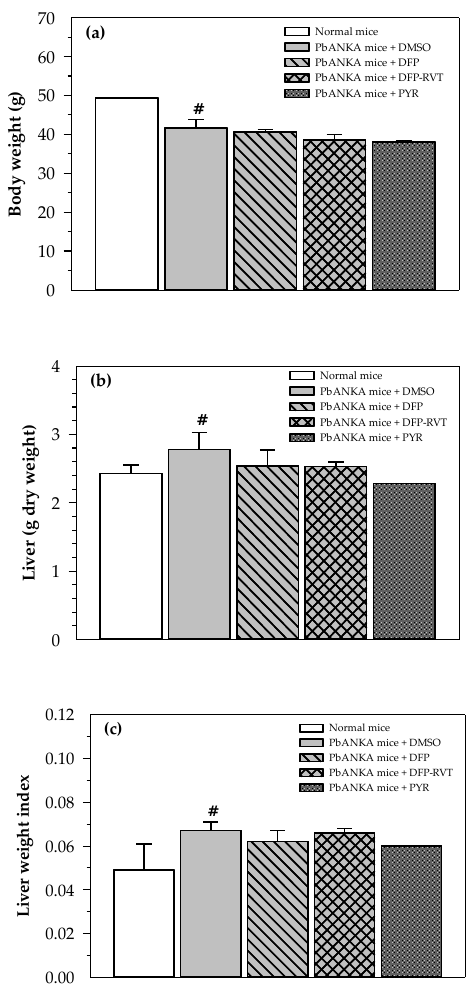
Figure 5. Body and liver weight, and liver weight index of normal mice and PbANKA-infected mice treated with DMSO, DFP, DFP-RVT and PYR. Male ICR mice were infected ip with PRBC suspension (1 × 10 7 cells/mL with 5–20% parasitemia), then orally administered with 60% DMSO, PYR (2 mg/kg BW), DFP (50 mg/kg BW) and DFP-RVT (50 mg/kg BW) every day for 4 d. Mice were then humanely euthanized. Body weights were recorded ( a ), while livers were removed and weighed ( b ), and converted to liver weight index ( c ). Data are expressed as mean ± SEM values. # p < 0.05 when compared to normal mice.